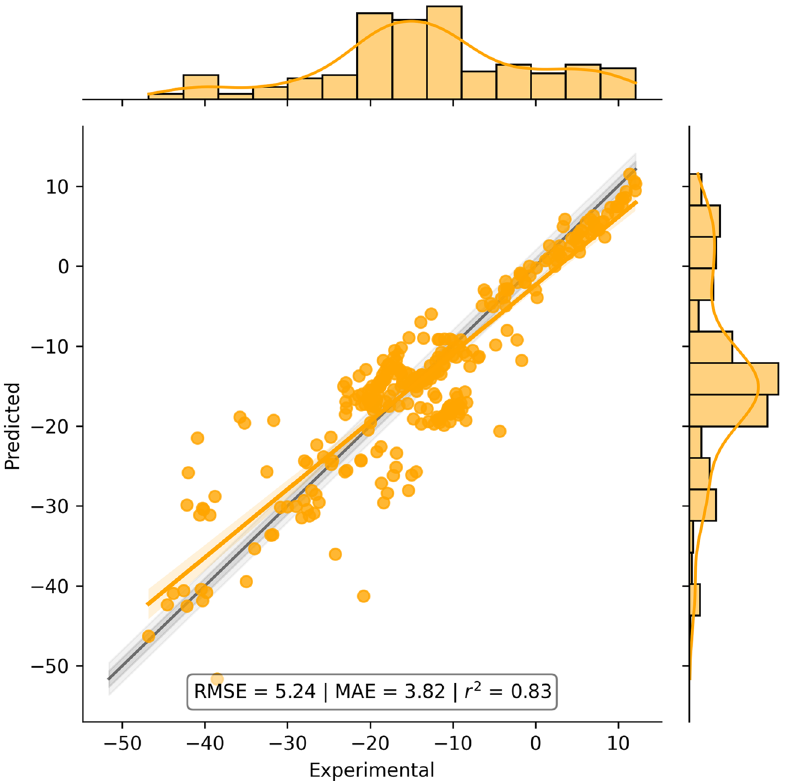
Figure 1. Correlation plot between predicted and experimental Hydration Free Energies from the data set described by Gerber. MAE and RMSE values are given in kJ mol −1